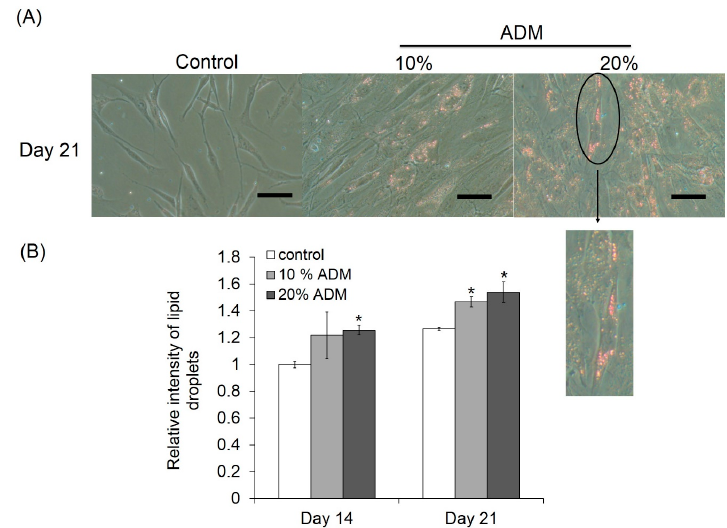
Figure 2. Lipid accumulation in human dermal fibroblasts, Hs68. ( A ) The cells were stained with Oil Red O solution after 21 days incubation with ADM to determine lipid droplet accumulation. (×200 magnification, Scale bar = 100 μ m); and ( B ) quantification of Oil Red O staining has showed that there is no apparent trend of O.D. value with ADM treatment. The results were expressed by the mean absorbance of Oil Red O residues dissolved in isopropanol compared to control ±standard deviation, n = 3. * p < 0.05 with respect to control.